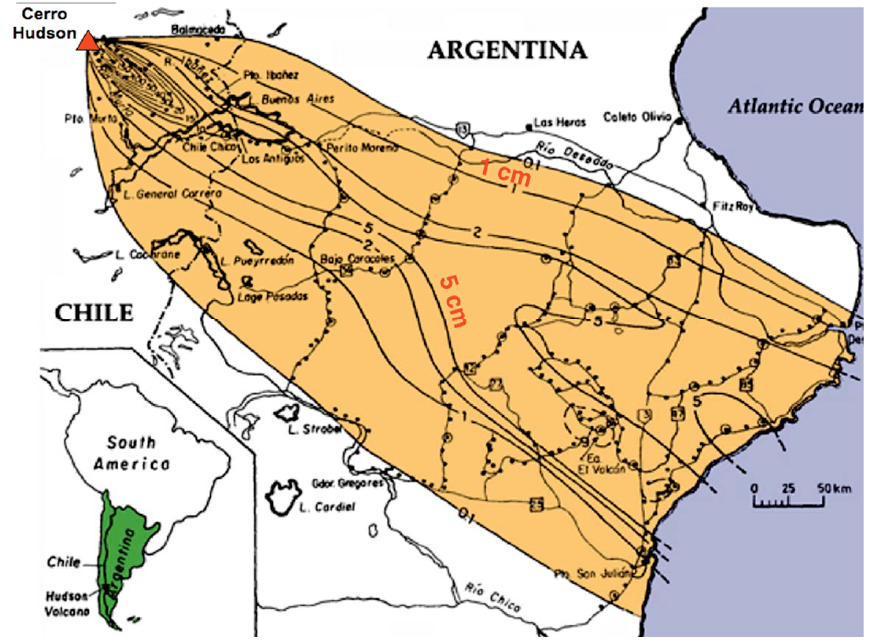
Fig. 8. Isopach map of the ashfall from the 1991 Cerro Hudson eruption, Chile. The 1 cm and 5 cm isopachs are indicated by red labels. [From Scasso and others, 1994, Fig. ?].